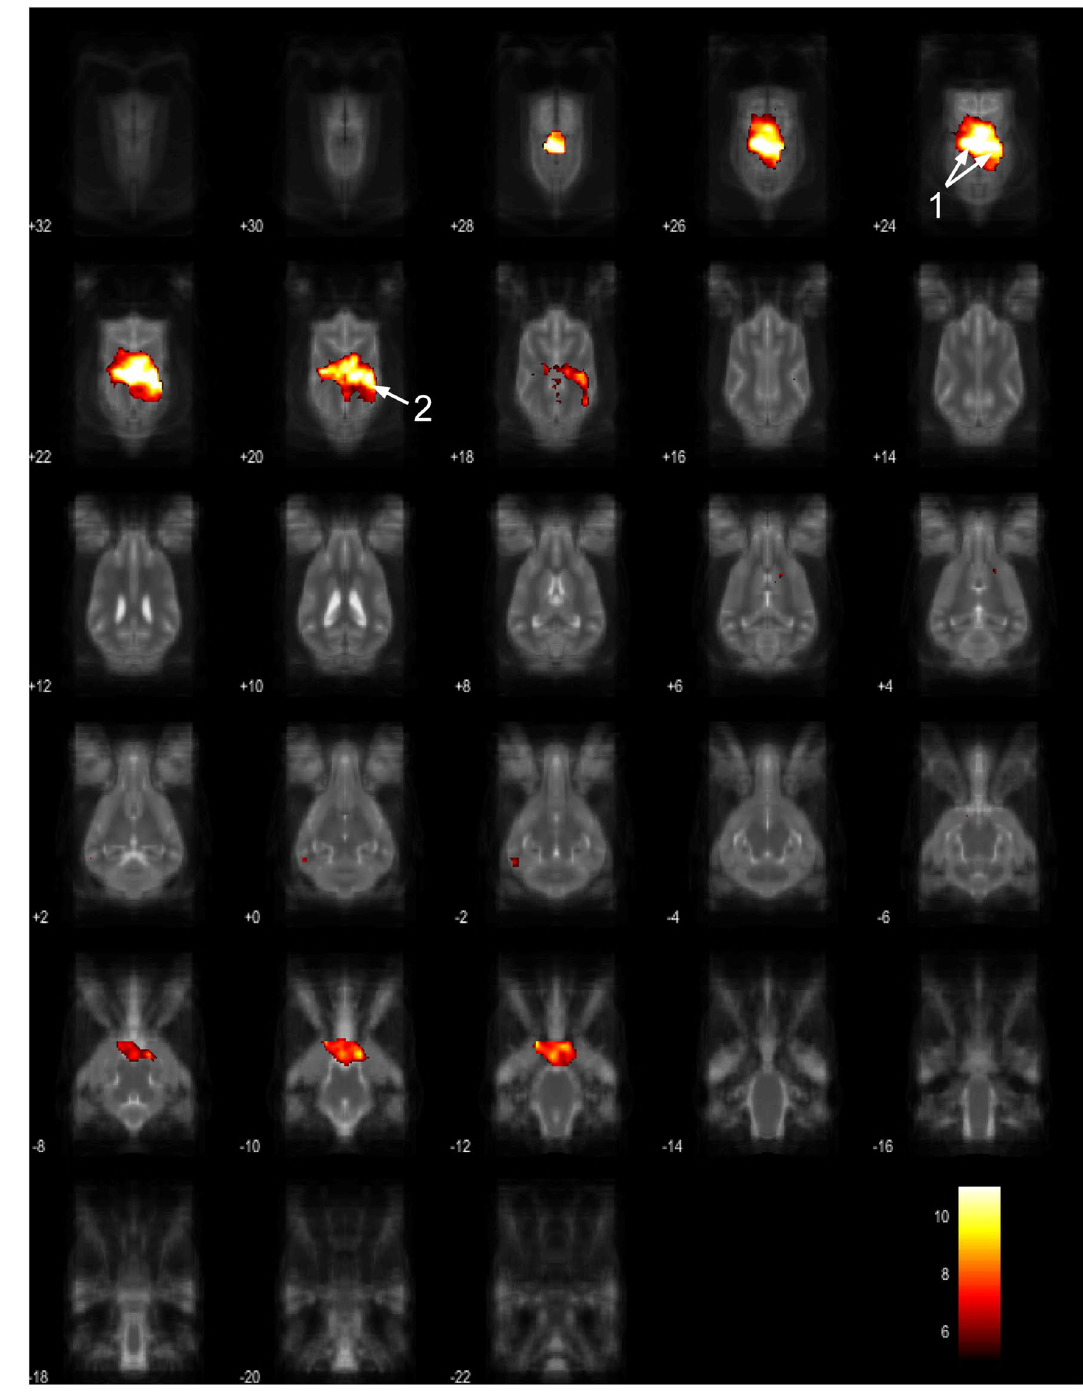
Figure 13. Resting-state network component J from the 15 component gICA. We report the results with a voxel-wise FDR corrected p < 0.001 and cluster treshold of FDR corrected p < 0.005. gICA components are presented as thresholded T-maps, corrected for multiple comparisons, overlaid on the Nitzsche atlas 15 . 1. bilateral marginal gyrus, 2. ectomarginal